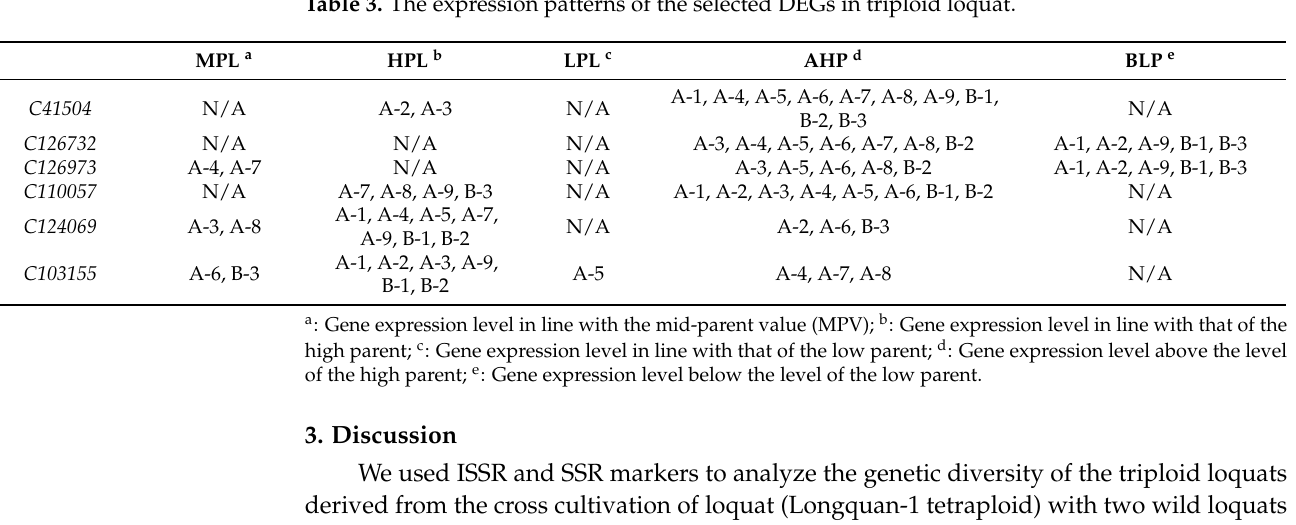
Figure 7. qRT-PCR validation of the growth-vigor-related DEGs, which were identified via RNA-Seq. Data are shown as means ± SD ( n = 3). Error bars denote |S|D. Table 3. The expression patterns of the selected DEGs in triploid